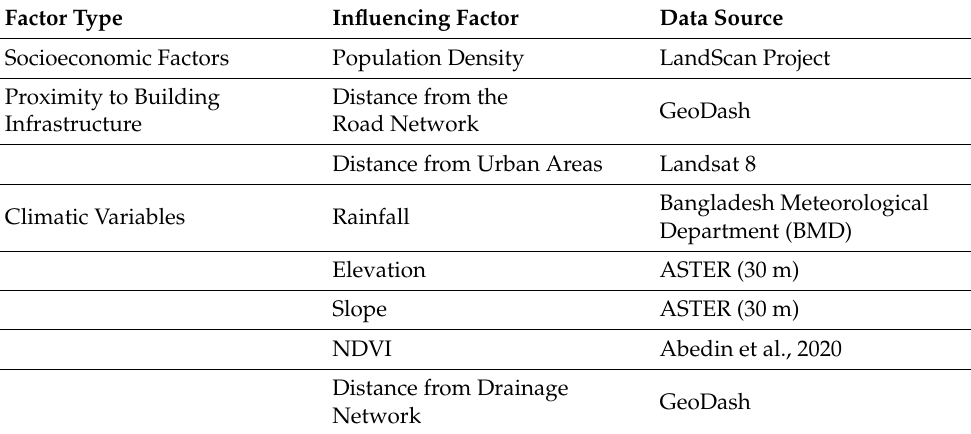
Table 1. Influencing factors of LULC in Rangamati municipality.